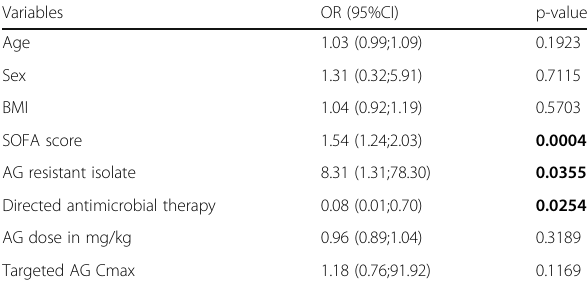
Table 1 (abstract 000363). See text for description